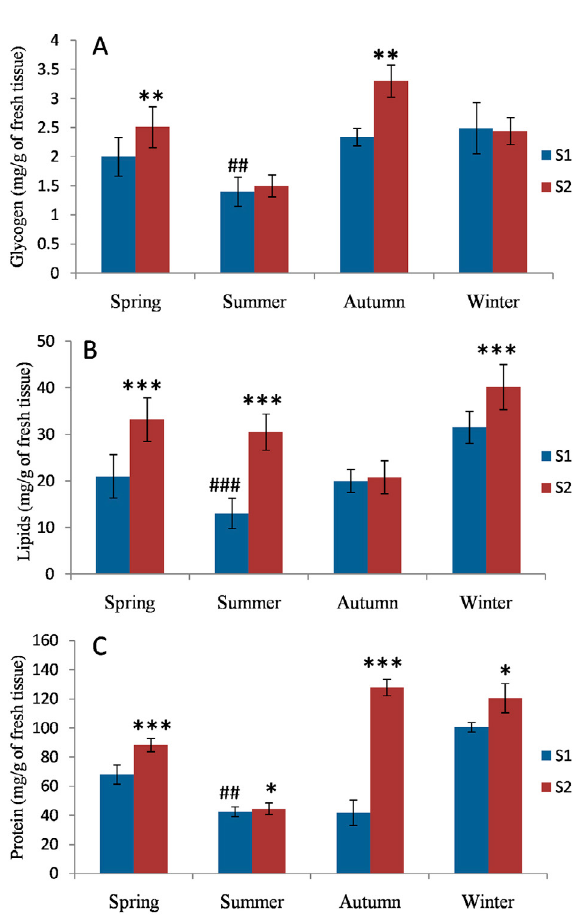
Fig.3. – Seasonal variation in the proximate fraction (mg/g ww) of P. cultrifera tissues collected from the port of Rades (S1) and the Punic port of Carthage (S2). (The results are represented as mean ± sd [n=20]). The statistical differences between sampling sites are represented at 5%: *p<0.05; **p<0.01 and ***p<0.001 using one-way ANOVA. The statistical differences between seasons are represented at 5%: #p<0.05; ##p<0.01 and ###p<0.001 using one- way